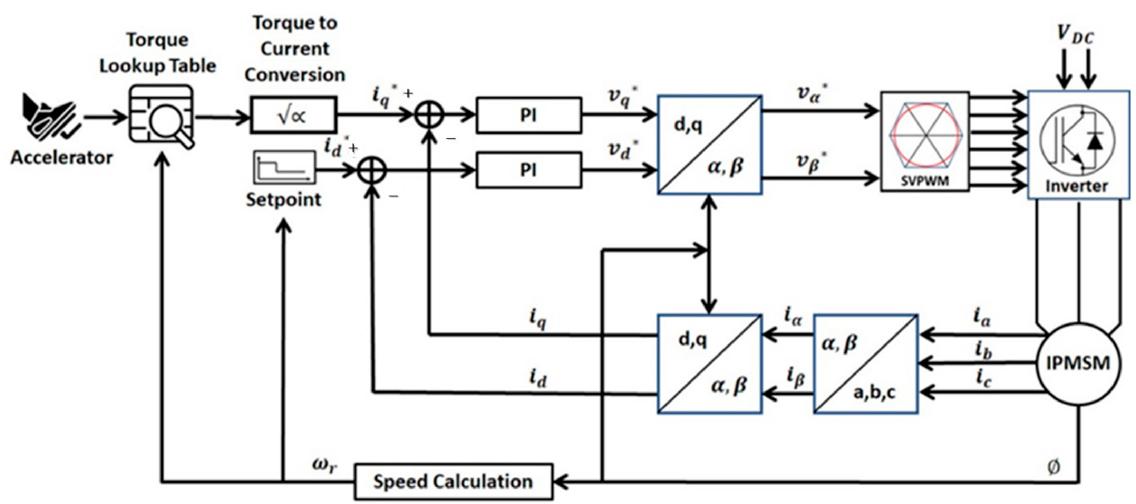
Figure 8. Proposed IPMSM lookup table-based controller block diagram.